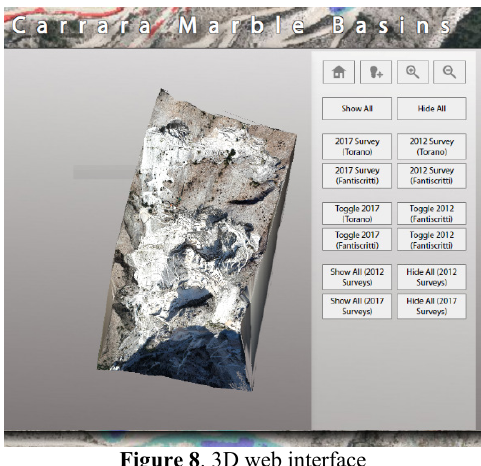
Figure 8 . 3D web